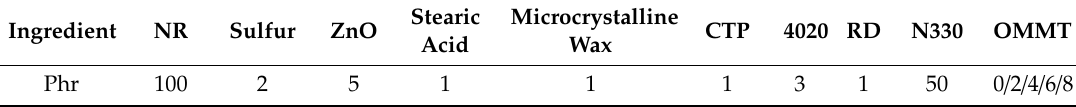
Table 1. Formula of natural rubber (NR) with organic montmorillonite (OMMT).